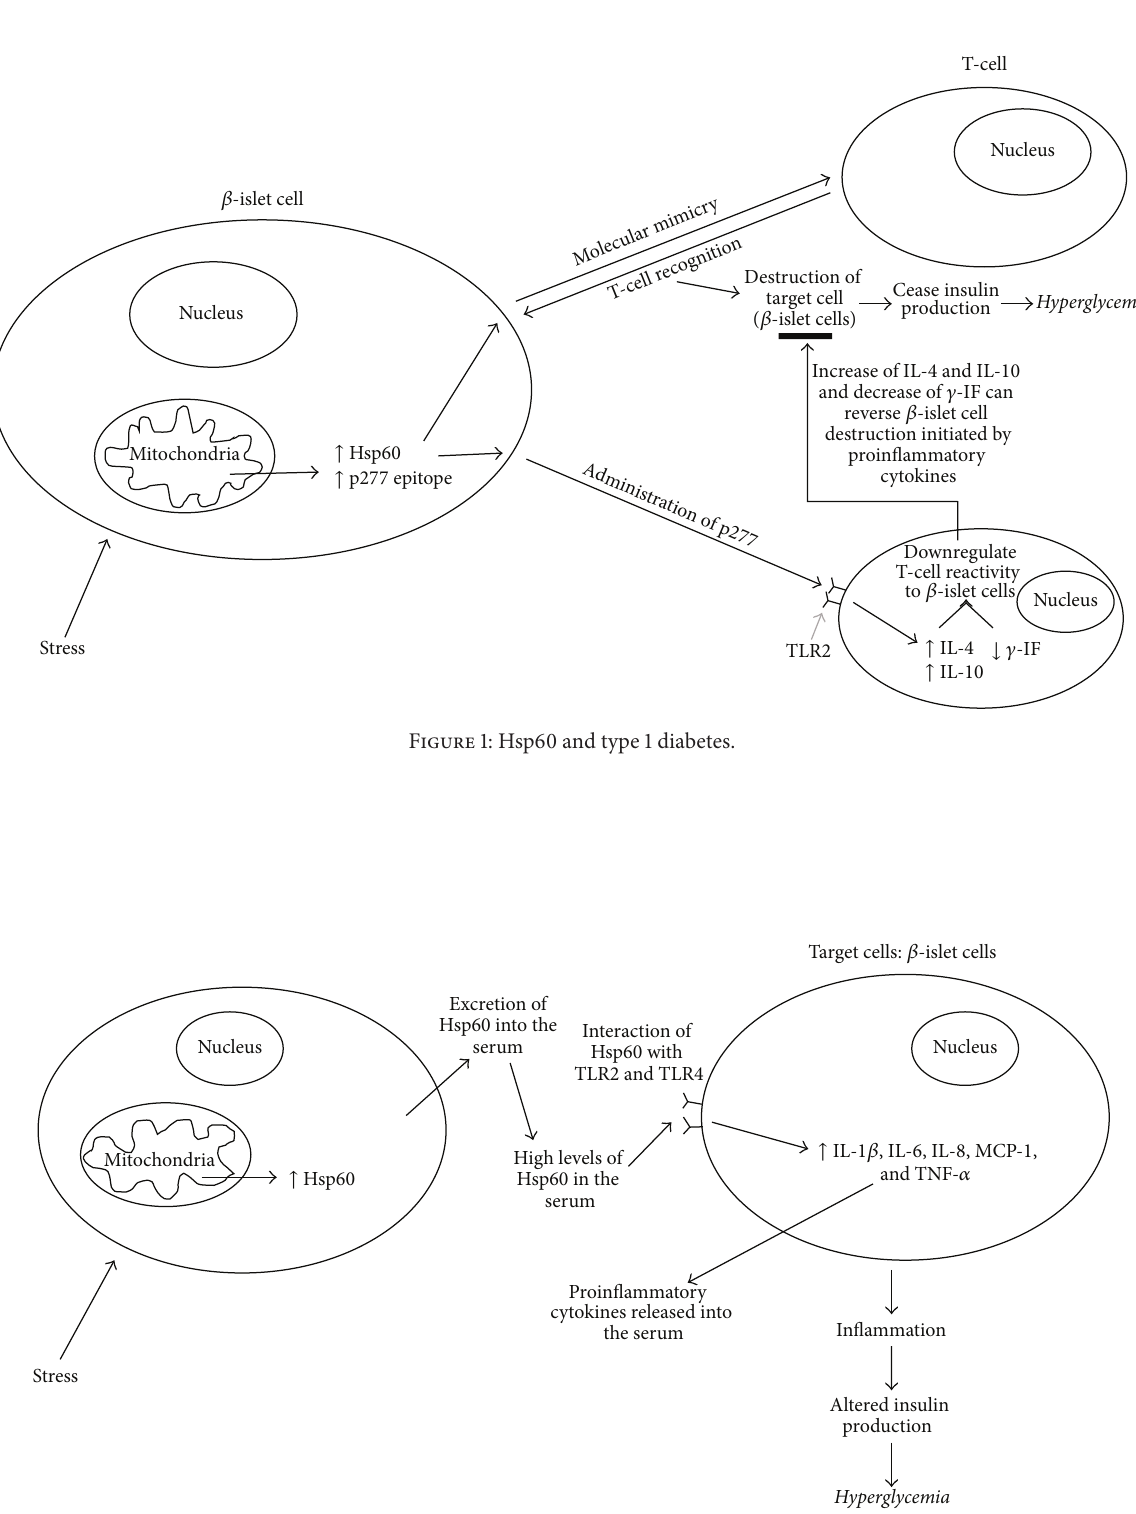
Figure 2: Hsp60 and type 2